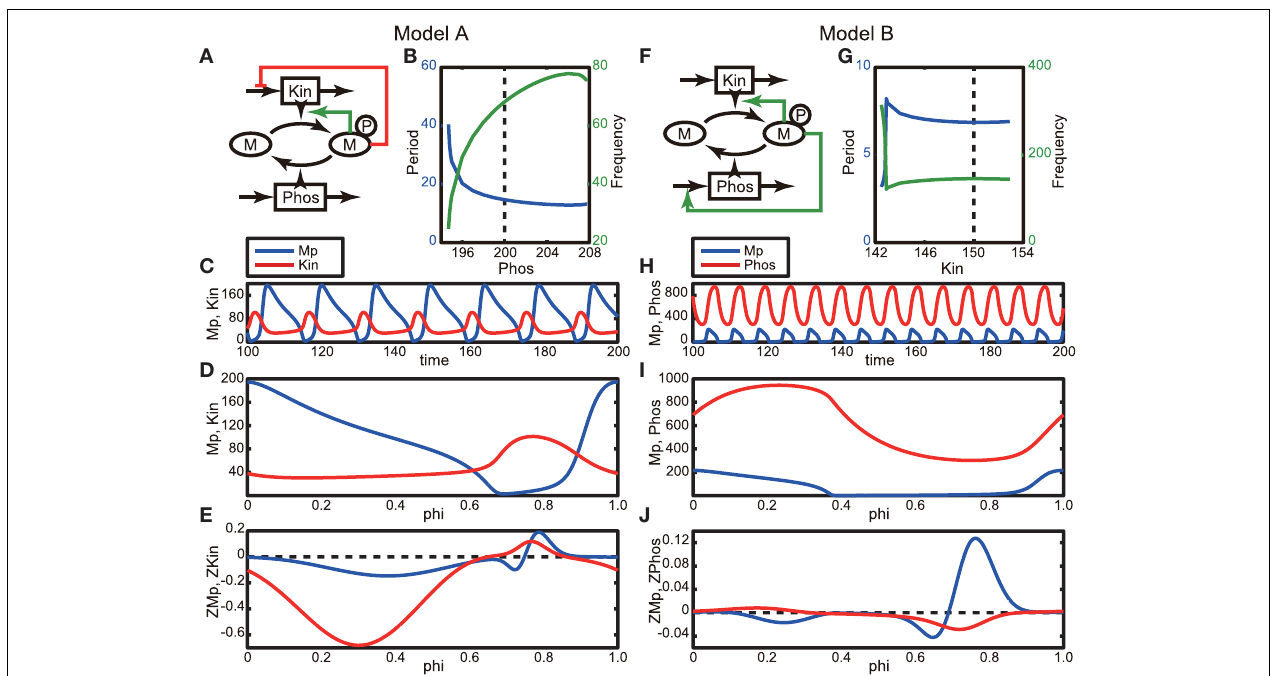
same as in (C) . (E) Phase response functions of the model, which are obtained by solving the adjoint equation given in Equation 4 (Ermentrout, 1996). Colors are the same as in (C) . (F) Schematic of Model B, in which the phosphorylated M, Mp, increases the production of phosphatase or activates its activity. Here, Kin takes a constant value, 150. (G–J) Same as in (B–E) , but here they are obtained using model B. Blue and red lines in (H–J) correspond to Mp and Phos,